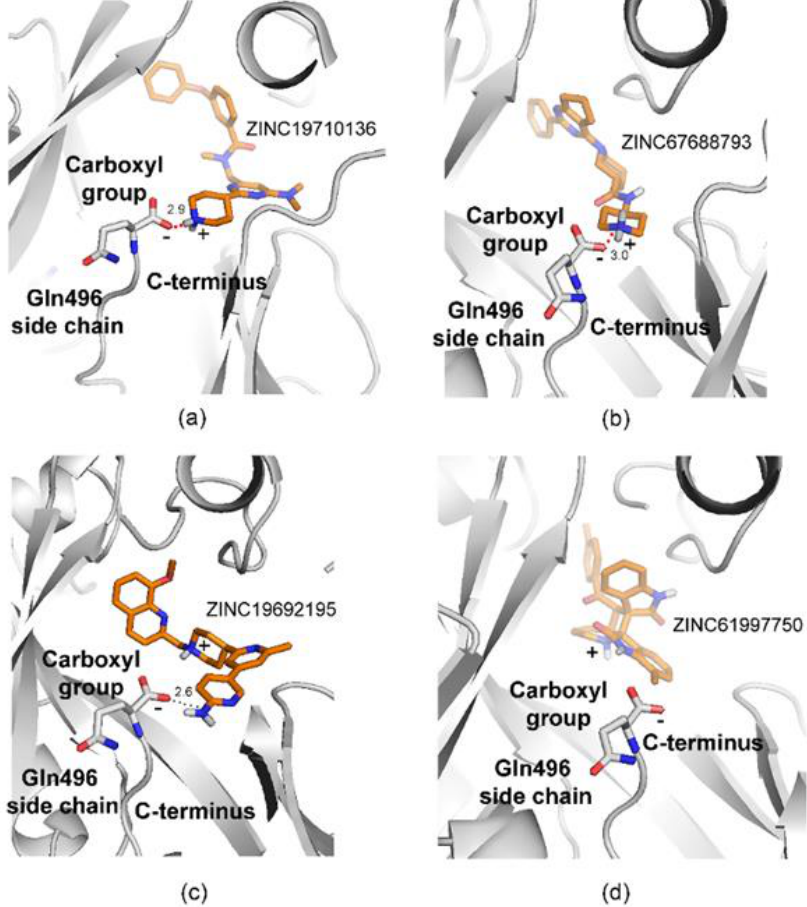
Figure 5. Examples of docking poses of ligands identified by virtual screening. The distances shown are in angstroms (Å). ( a ) ZINC19710136 forms a salt bridge with C-terminus of NMT1. ( b ) ZINC67688793 forms a salt bridge with C-terminus of NMT1. ( c ) ZINC1969215 participates in a hydrogen bond with the C-terminus of NMT1. The charge of the small molecule is located in a central piperidine ring and is not involved in the formation of a salt bridge ( d ) ZINC61997750 occupies a complementary region and does not interact with the C-terminus of NMT1. The docking was performed using GOLD with flexible ligand and flexible amino acid side chains settings. The images were produced in